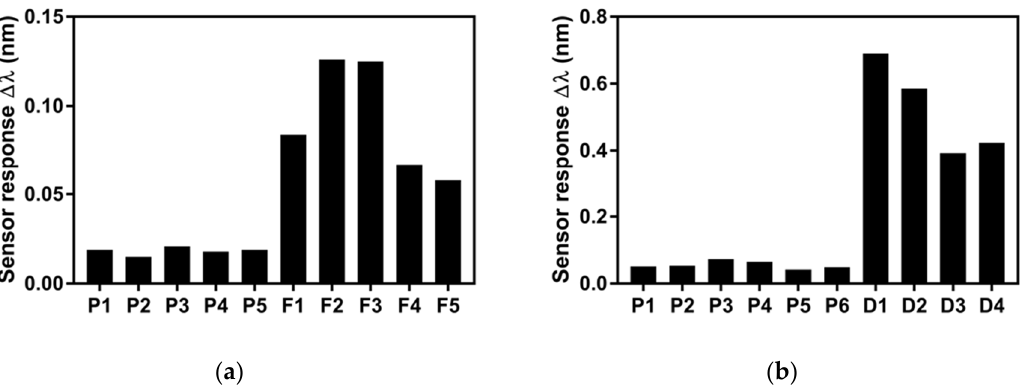
Figure 6. Detection of mtLSU rRNA gene contained in synthetic pGEM-T Easy plasmids and DNA fragments. ( a ) Sensor signal corresponding to pGEM-T Easy plasmids (P) and ds-DNA fragments (F). ( b ) Sensor signal corresponding to pGEM-T Easy plasmids (P) and pGEM-T Easy plasmids digested (D) by EcoRI enzyme. For all the measurements SSC 2.5 X + 5% FA as running buffer and PPRH: CH 3 –PEG (1:1) monolayers were performed.